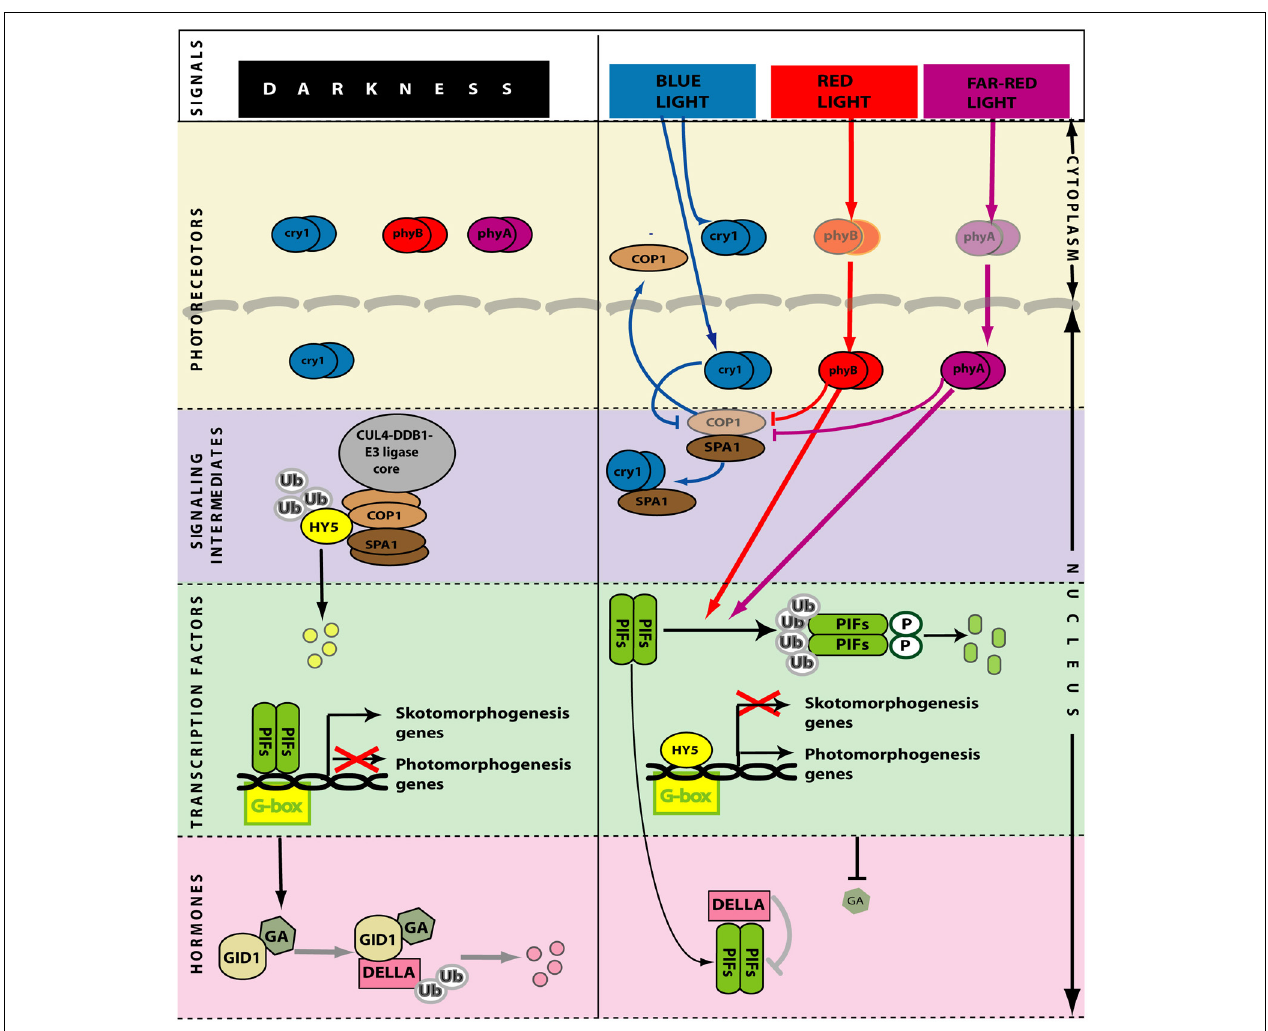
FIGURE 4 | Simplified model of light perception and signaling during de-etiolation. In darkness ( left ) the photoreceptors are inactive. PIF transcription factors promote skotomorphogenesis. HY5 and other transcription factors that promote photomorphogenesis are ubiquitinated by CUL4-DDB1 COP1 − SPA1 E3 ligase complex and degraded in the 26S proteasome. High levels of gibberellins induce degradation of DELLA. Light ( right ) activates the photoreceptors. In